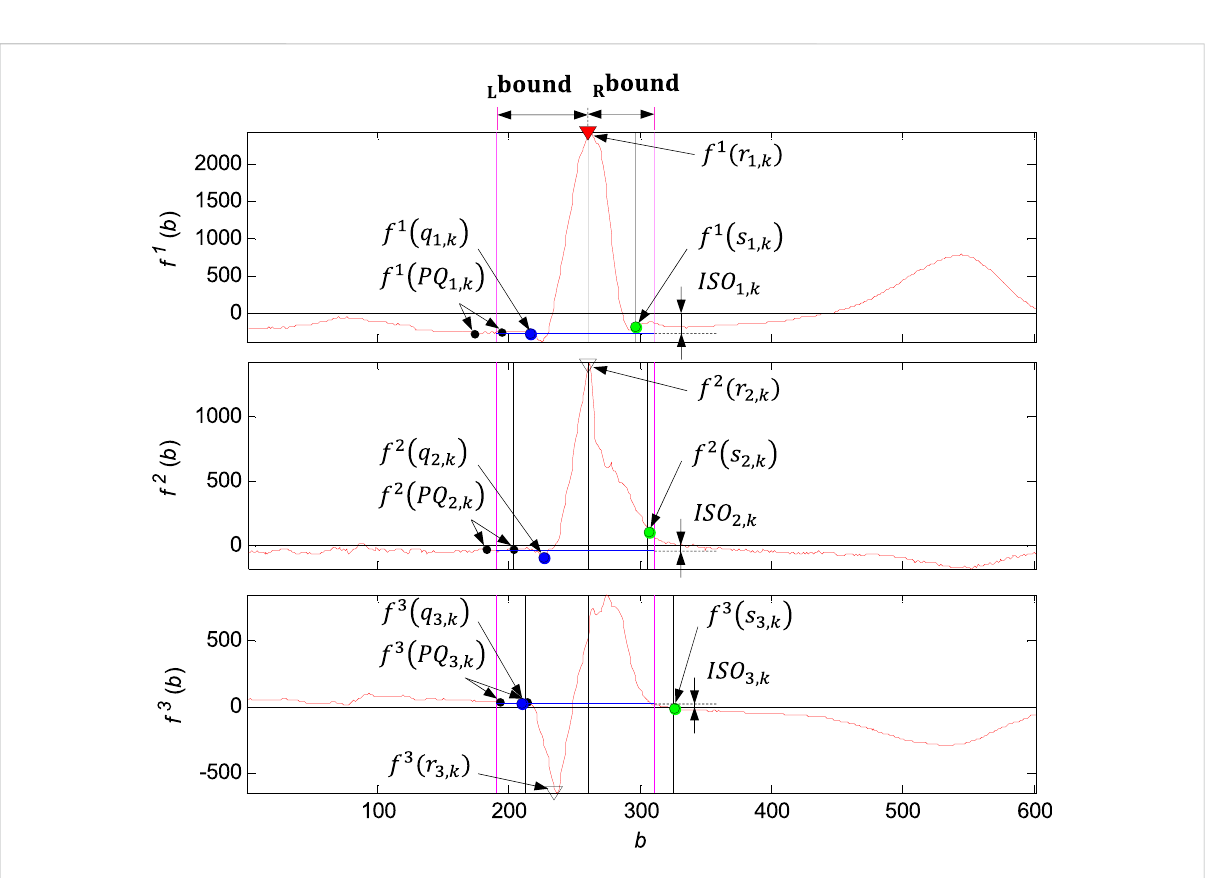
FIGURE 11 IllustrationoftheQRSloopboundariesdetectionandtheindividualtimeinstants q i , k , r i , k , s i , k , PQ i , k .Thefunctionvalueinthesynchronisingpoint r 1 , k is marked by the red triangle, next there are marked the function values in the points the QRS onsets (blue circle), function values in the points s i , k of the QRS ends (green circle), function values in the points of the PQ i , k sets of the PQ segments (black circle). The boundaries of the QRS loop L bound, R bound marked with violet colour. Isoelectric coordinates ISO i , k marked with blue isolelectric